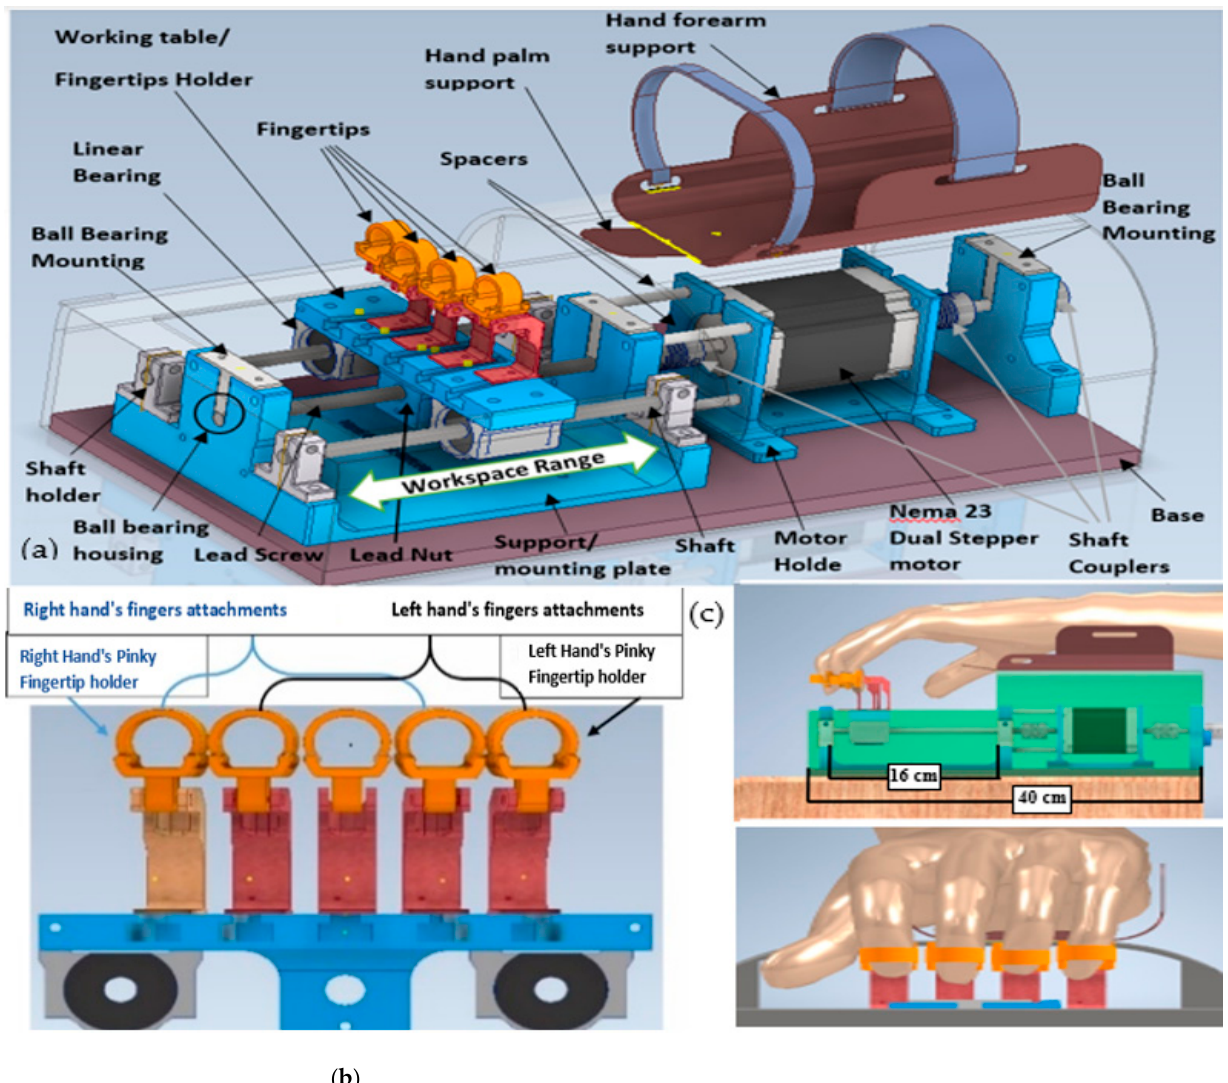
Figure 3. The grounded-exoskeleton of the fingers rehabilitation: mechanism design: ( a ), The Finger rehabilitation indirect feed drive screw and nut mechanism design with all parts; ( b ) front view of the worktable with exoskeleton fingertips design, since the fingers’ anthropometric and positions of the right and the left hand, are not the same, especially the pinky finger. Therefore, we designed five adjustable fingertips holder to be suitable for either hand’s pinky finger; ( c ), side view 3D structure model of the FWRMS device and human finger interaction; ( d ), Front view, 3D structure model of the human finger-robot